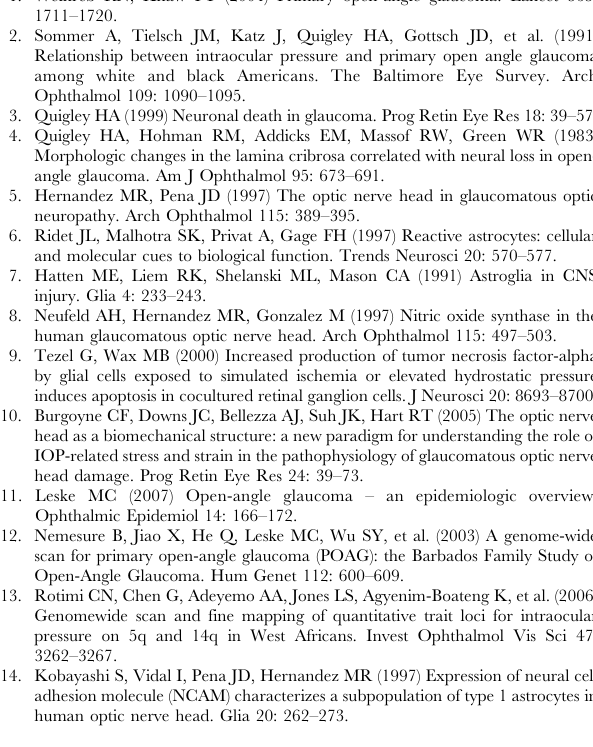
Table S4 Functional analysis of genes differentially expressed in AA vs. CA. Functional classification of genes differentially expressed in AA ONH astrocytes compared to and CA ONH astrocytes.